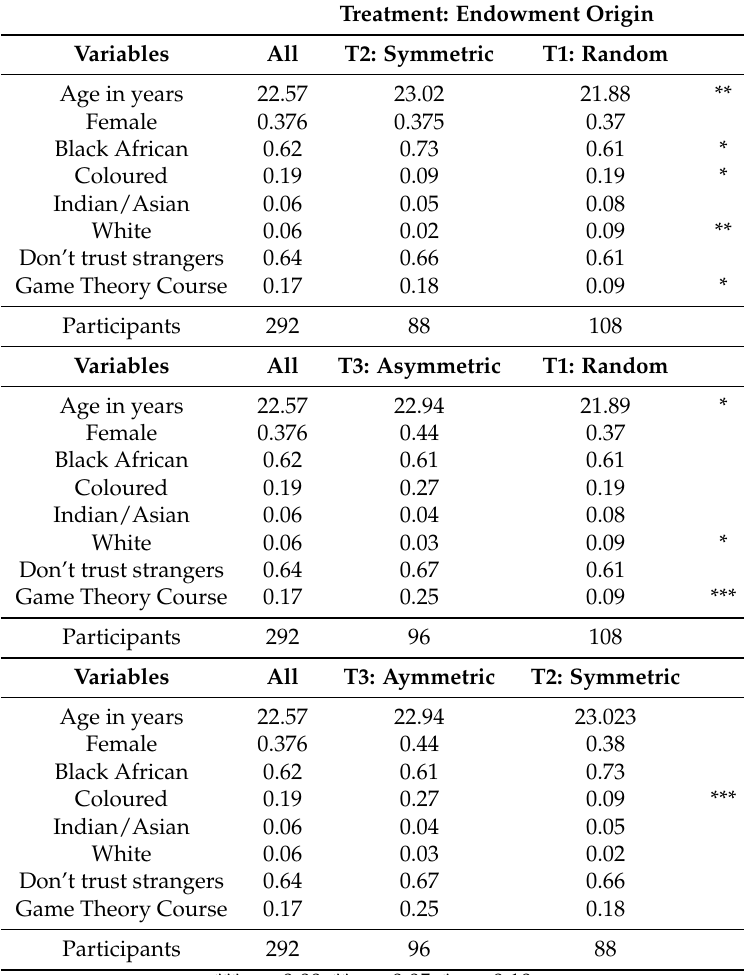
Table 2. Descriptive Statistics: Participant